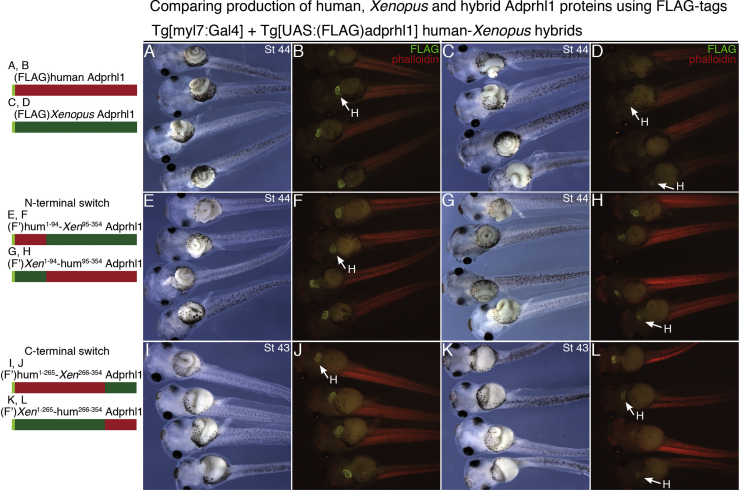
Comparing production of human, Xenopus and hybrid Adprhl1 proteins in transgenic tadpoles with FLAG-tags. The illustrations on the left indicate the composition of the human-Xenopus hybrid Adprhl1 proteins used in the experiment. A, B: Four representative transgenic tadpoles that express human ADPRHL1 protein in their hearts. Each tadpole carries the driver Tg[myl7:Gal4] transgene plus a new integration of a Tg[UAS:(FLAG)human ADPRHL1] responder transgene. Ventral view of stage 44 tadpoles (A) and matching fluorescence image (B) shows anti-FLAG immunocytochemistry (green) and phalloidin stain in the tail (red). C, D: Sibling tadpoles express little recombinant Xenopus Adprhl1 protein, despite having the same driver but a new integration of a Tg[UAS:(FLAG)Xenopus adprhl1] responder transgene. A weak signal for the FLAG epitope is only detected in a few myocardial cells with this Xenopus-species transgene. E–L: Transgenic tadpoles that express human-Xenopus hybrid Adprhl1 identify the 5′-cDNA (N-terminal) region as the site of regulation of the Xenopus protein. E, F: Tadpoles that carry the driver and a N-terminal switched, Tg[UAS:(FLAG)human1-94-Xenopus95-354adprhl1] responder transgene now produce detectable recombinant Adprhl1, because of the presence of the human sequence. G, H: Tadpoles with the driver and the converse Tg[UAS:(FLAG)Xenopus1-94-human95-354adprhl1] responder transgene still produce recombinant Adprhl1, although less (and in fewer animals) than the entirely human-species transgene (S. Table I). I, J: Tadpoles with the driver and a C-terminal switched, Tg[UAS:(FLAG)human1-265-Xenopus266-354adprhl1] produce expected levels of recombinant Adprhl1. K, L: Tadpoles with the driver and the converse Tg[UAS:(FLAG)Xenopus1–265-human266-354adprhl1] responder transgene express little recombinant Adprhl1, similar to the entirely Xenopus-species FLAG-tagged transgene. H, heart.